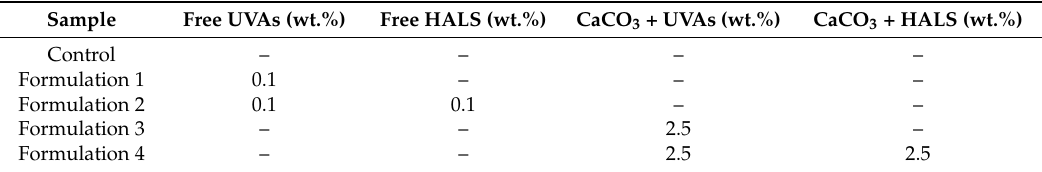
Table 2. Composition of the